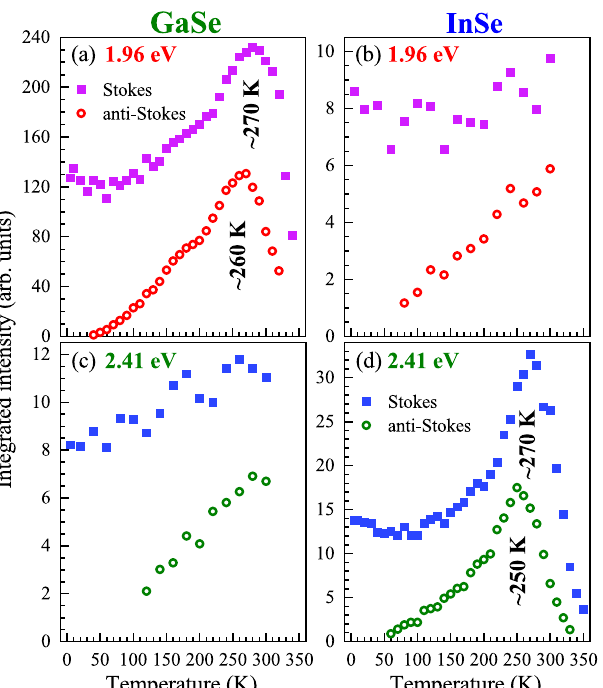
Figure 4. Temperature evolution of the Stokes- (full square points) and anti-Stokes-related (open circle points) ′ intensities for the A 1 (1) modes measured on ( a ),( c ) GaSe and ( b ),( d ) InSe under excitation of ( a ),( b ) 1.96 eV and ( c ),( d ) 2.41